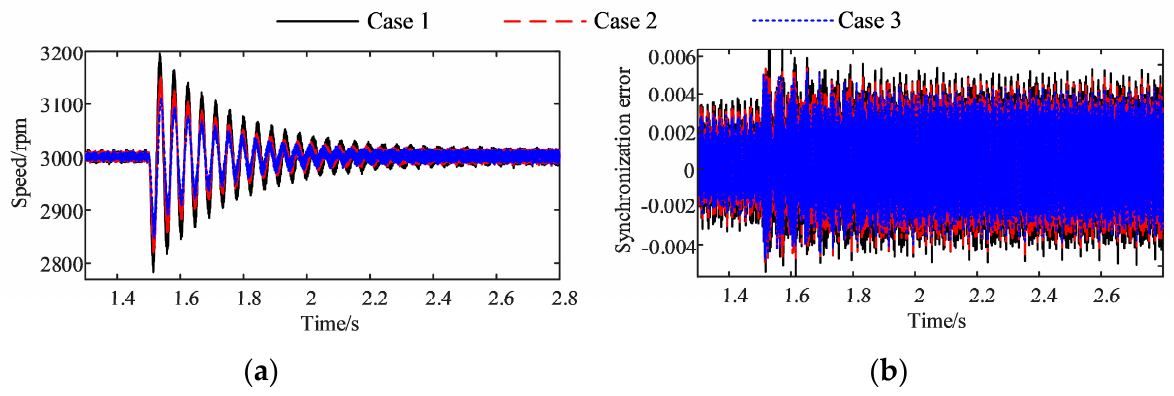
Figure 25. Motor 1 speed and synchronization error under different combinations of PI parameters: ( a ) motor 1 speed; ( b ) synchronization error.